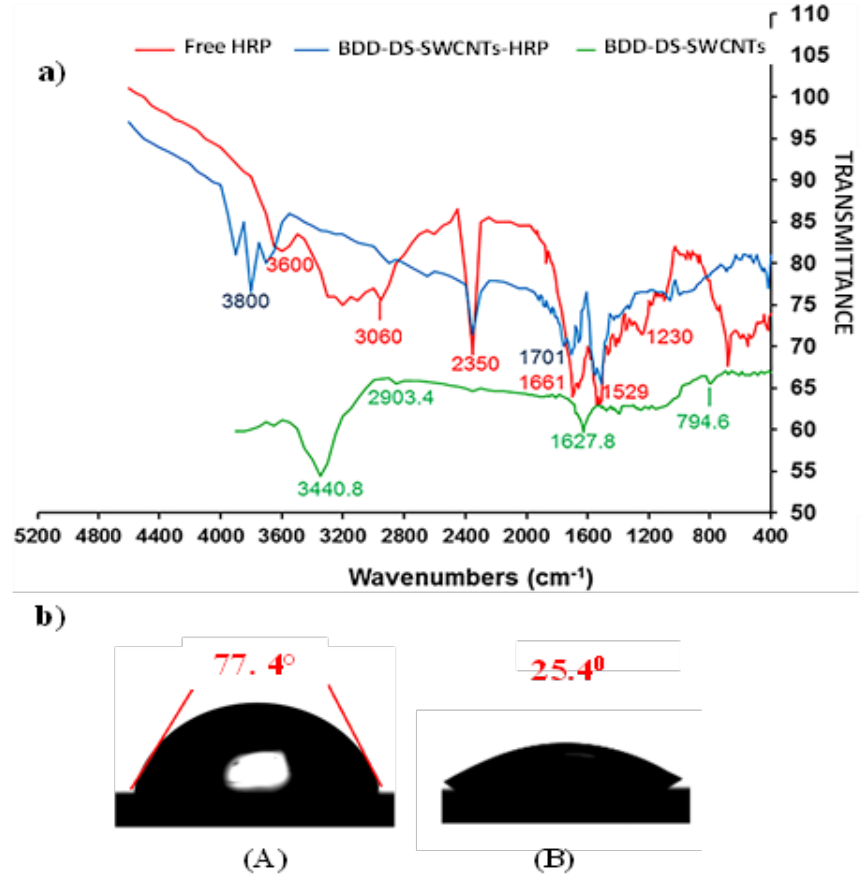
Figure 6. ( a ) FTIR spectra for free HRP, BDD/DS/SWCNTs and BDD/DS/SWCNTs/HRP, ( b ) angle of contact measurements of BDD surface ( A ) before and ( B ) surface modification with SD-SWCNTs.